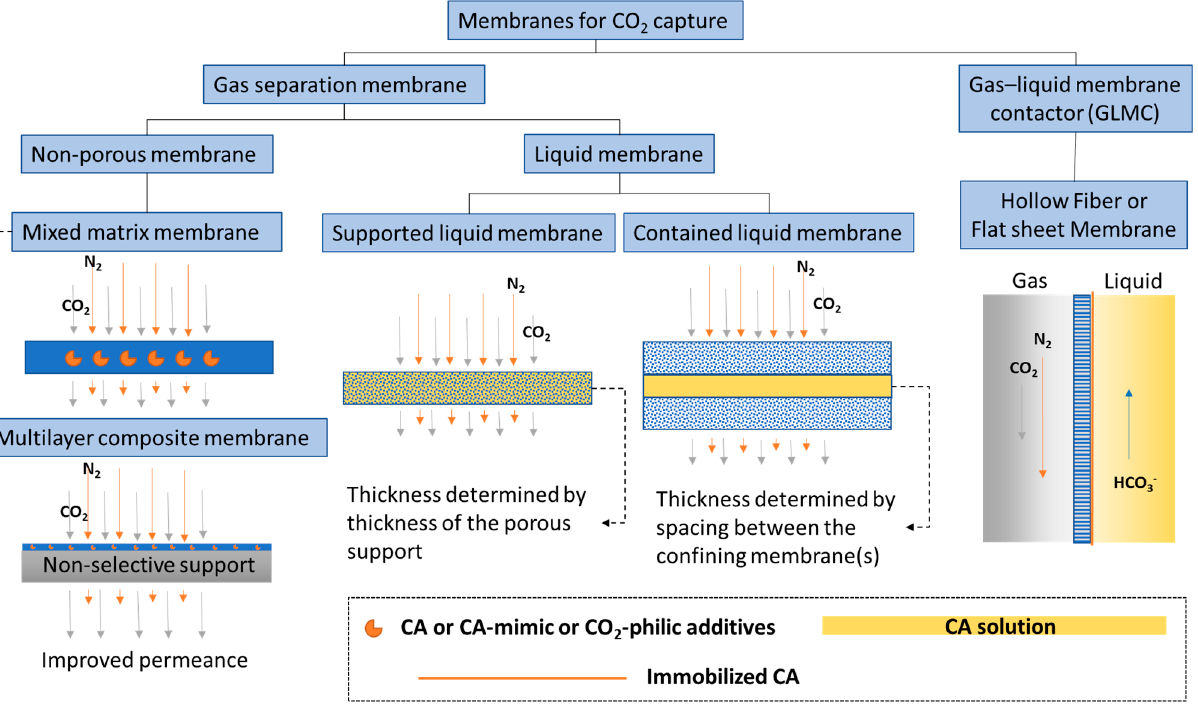
Figure 1. Categories of biocatalytic membranes used for CO 2